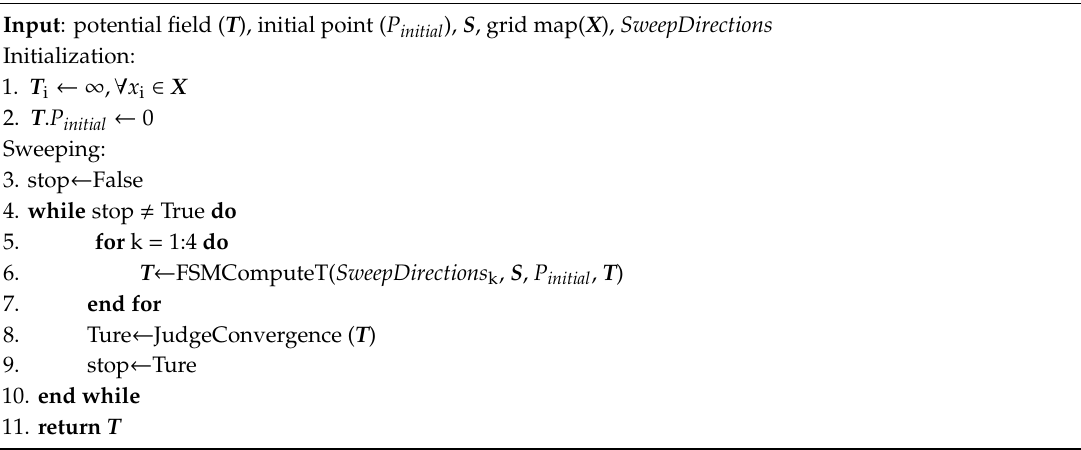
Algorithm 1. Fast Sweeping Method